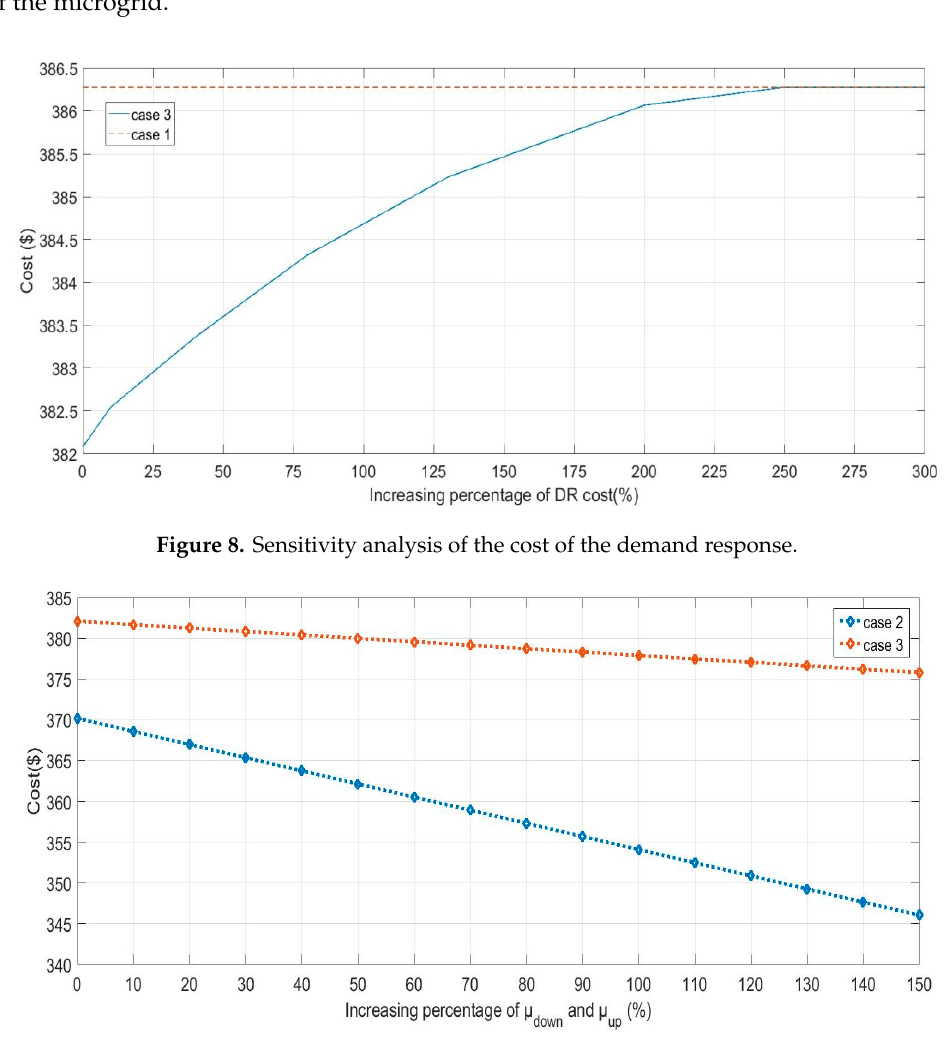
Figure 9. Sensitivity analysis of the maximum ratios of the shiftable load (down and up).